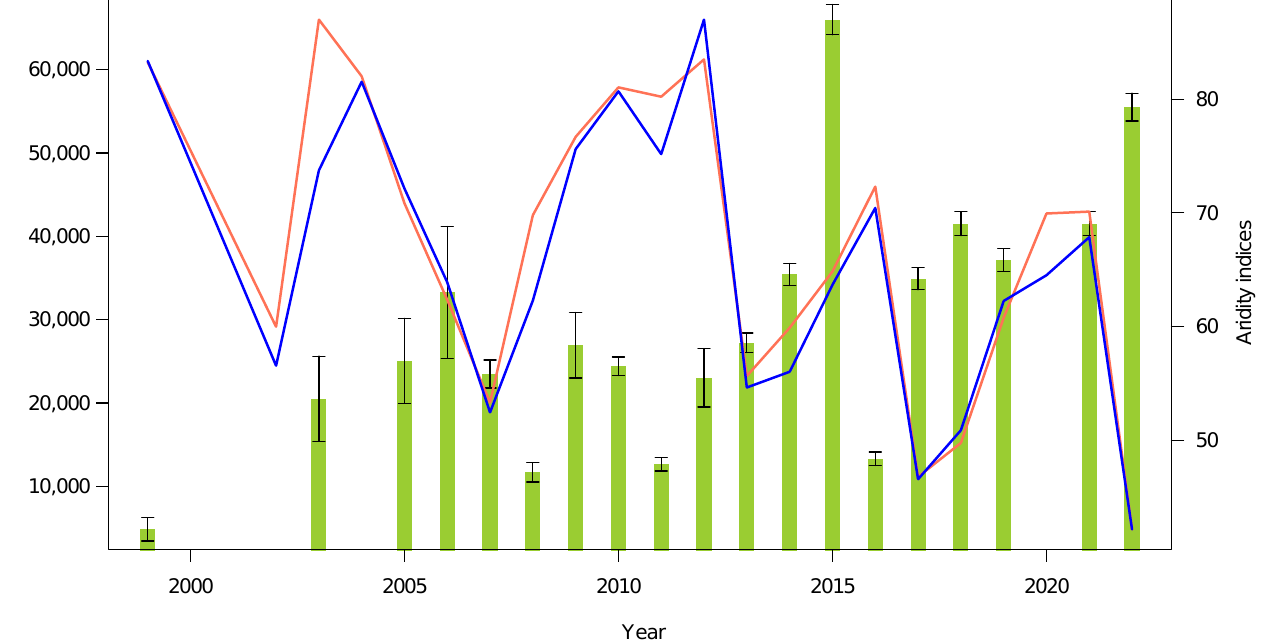
Figure 3. Annual density estimations of Helicodiceros muscivorus in high-density area (H.D.) of Aire Island. Left y -axis: green bars correspond to H. muscivorus density (individuals/ha ± SE) from 1999 to 2022. Right y -axis: values of Emberger’s aridity index (blue line) and Iq index (red line, see more details in the text). The highest plant density is recorded in 2015, with more than 60,000 plants/hec- tare.